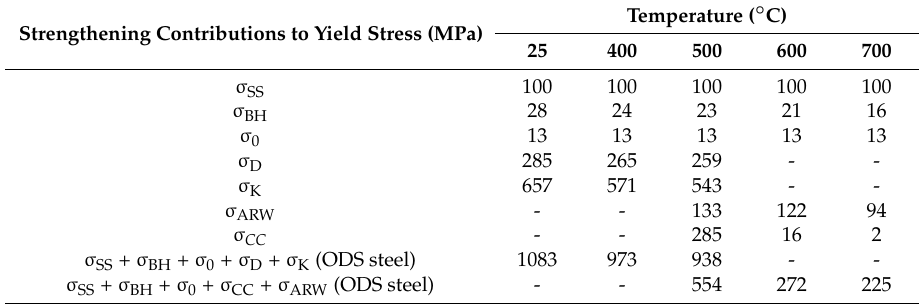
Table 3. Strengthening contributions to yield stress at 25, 400, 500, 600, and 700 ◦ C for ODS steel.